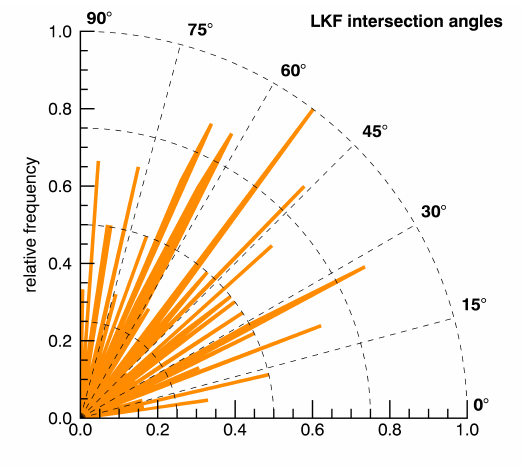
Figure 15. LKF intersection angles (bin size = 1 ◦